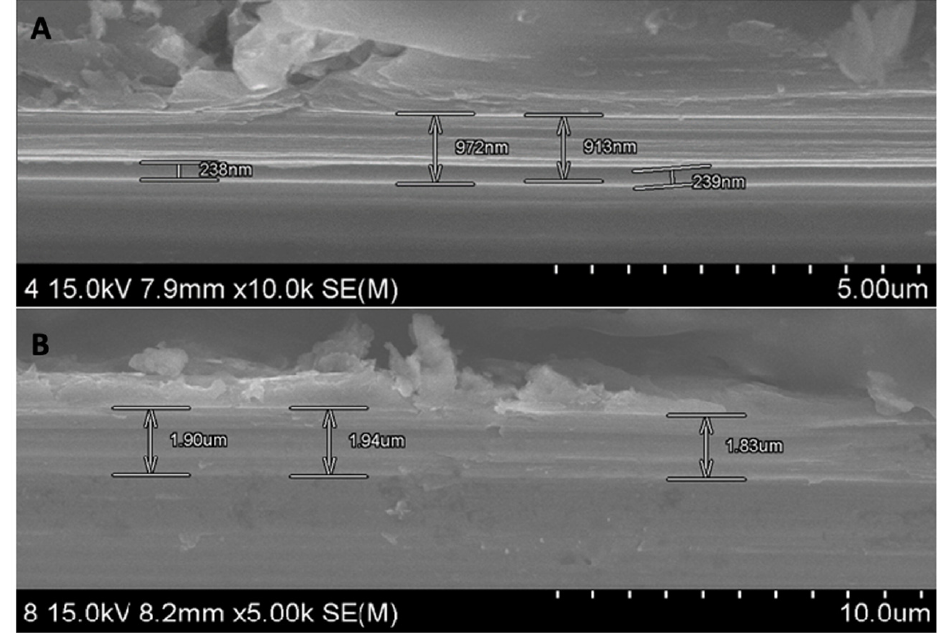
Figure 4. Thickness of MLTRP on Ti measured through FE-SEM. ( A ) 2-MLTRPB-Ti implant and ( B ) 3-MLTRPB-Ti implant.